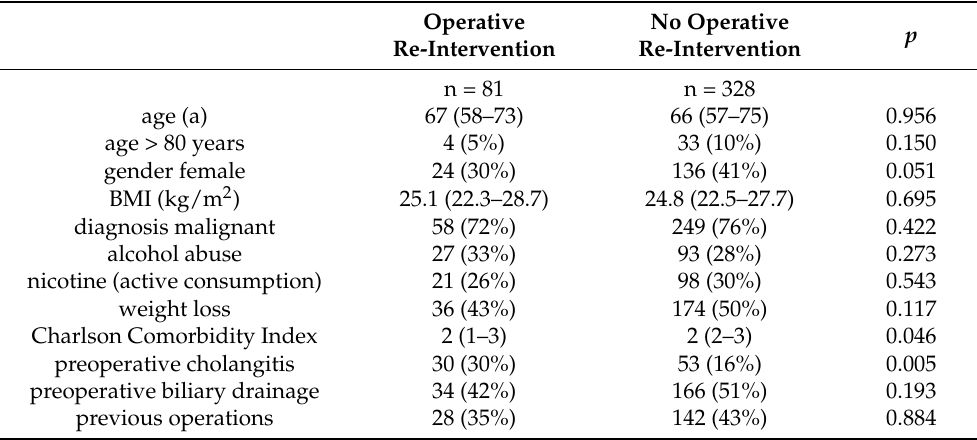
Table 1. Demographic and perioperative data of index operation.